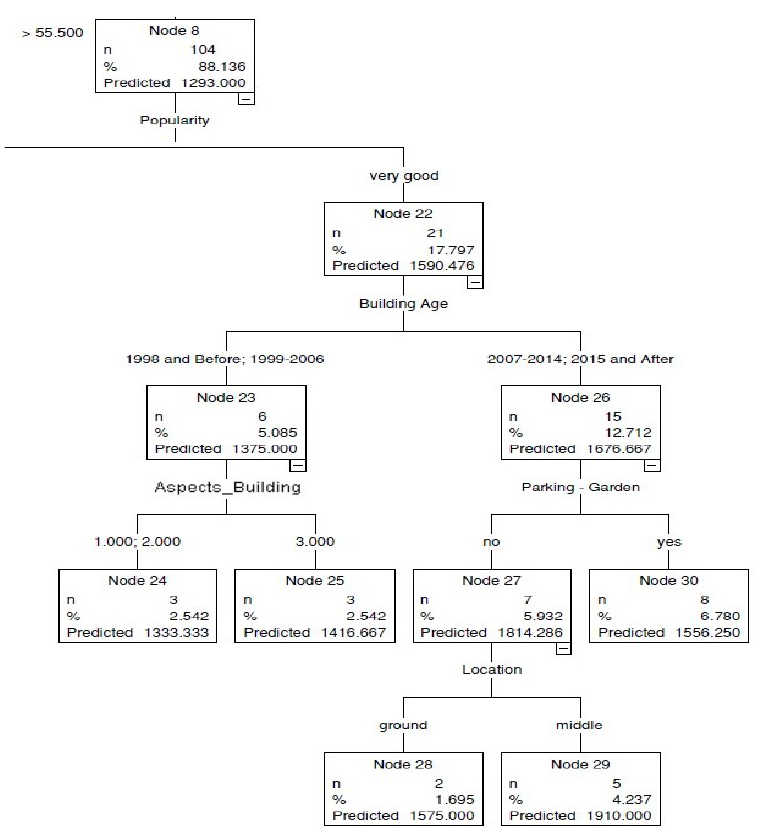
Fig. 10. Decision tree node 22 and the estimated real estate unit value (developed by the